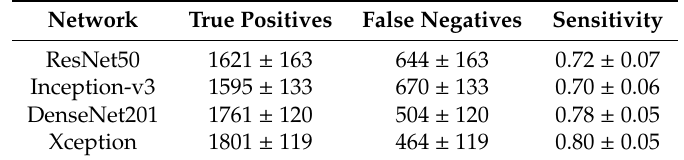
Table 8. Test Performance using enhanced baseline method that included preprocessing on the BIMCV dataset.